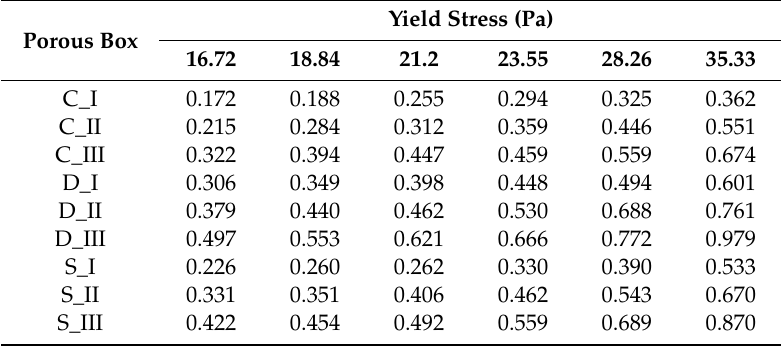
Table 3. Inclination of the final distribution in the nine porous boxes.